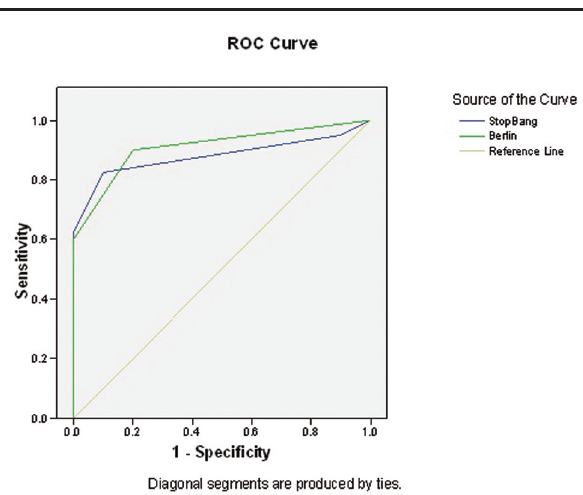
Receiver operating characteristic (ROC) curve analysis of STOP- BANG questionnaire and Berlin questionnaire for the prediction of severe OSAHS patients. OSAHS, obstructive sleep apnea hypopnea syndrome